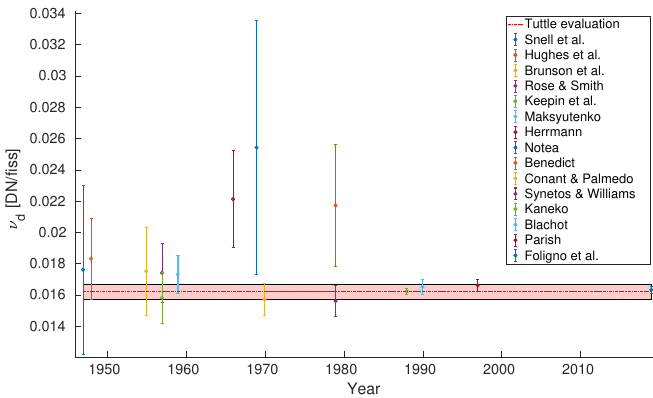
Figure 6: Experimentally measured ν d for 235 U Table 1: Results of the ALDEN experiment. Foligno et al. are the results of the fit while WPEC-6 are the values recommended by the WPEC-SG6 Quantity of interest Foligno et